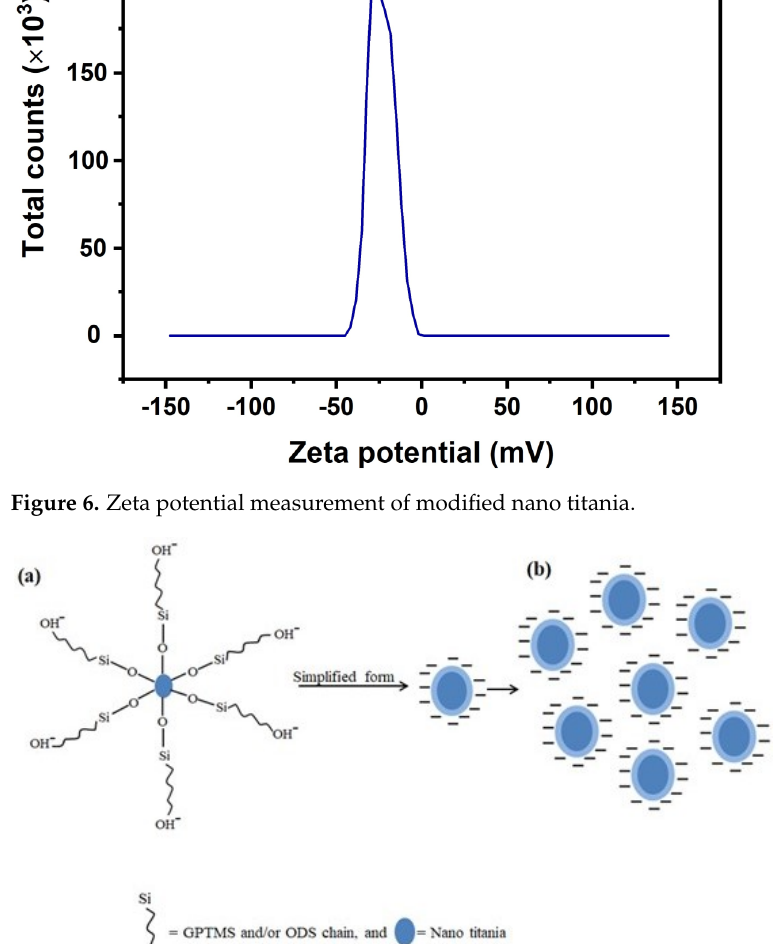
Figure 6. Zeta potential measurement of modified nano titania.